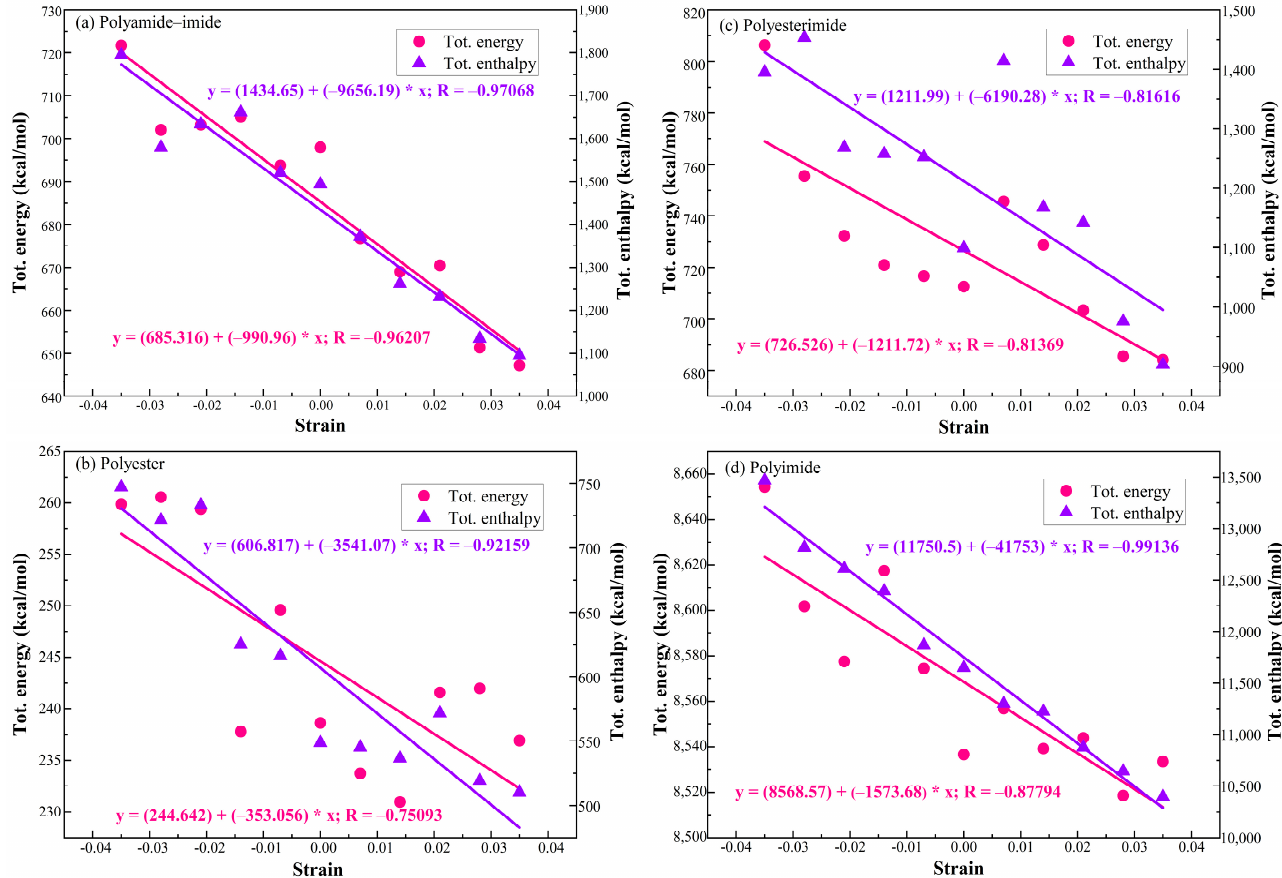
Figure 8. Amorphous cell energy–strain curves for PAI, PET, PEI and